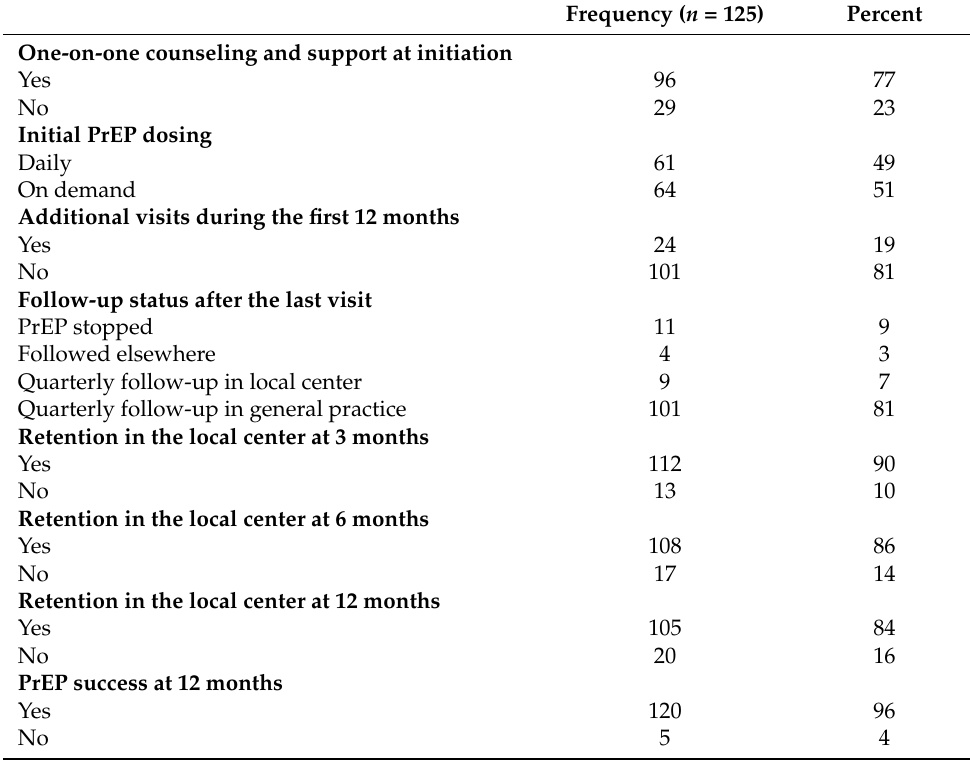
Table 2. Course of care and successful HIV pre-exposure prophylaxis at 12